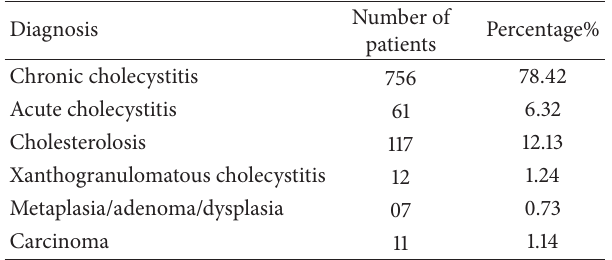
Table 1: Common presenting symptoms. Table 2: Histopathological findings of resected gall bladder speci-